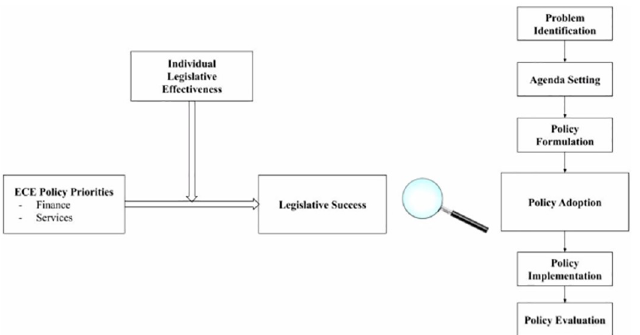
Fig 1. Conceptual model of early childhood legislative